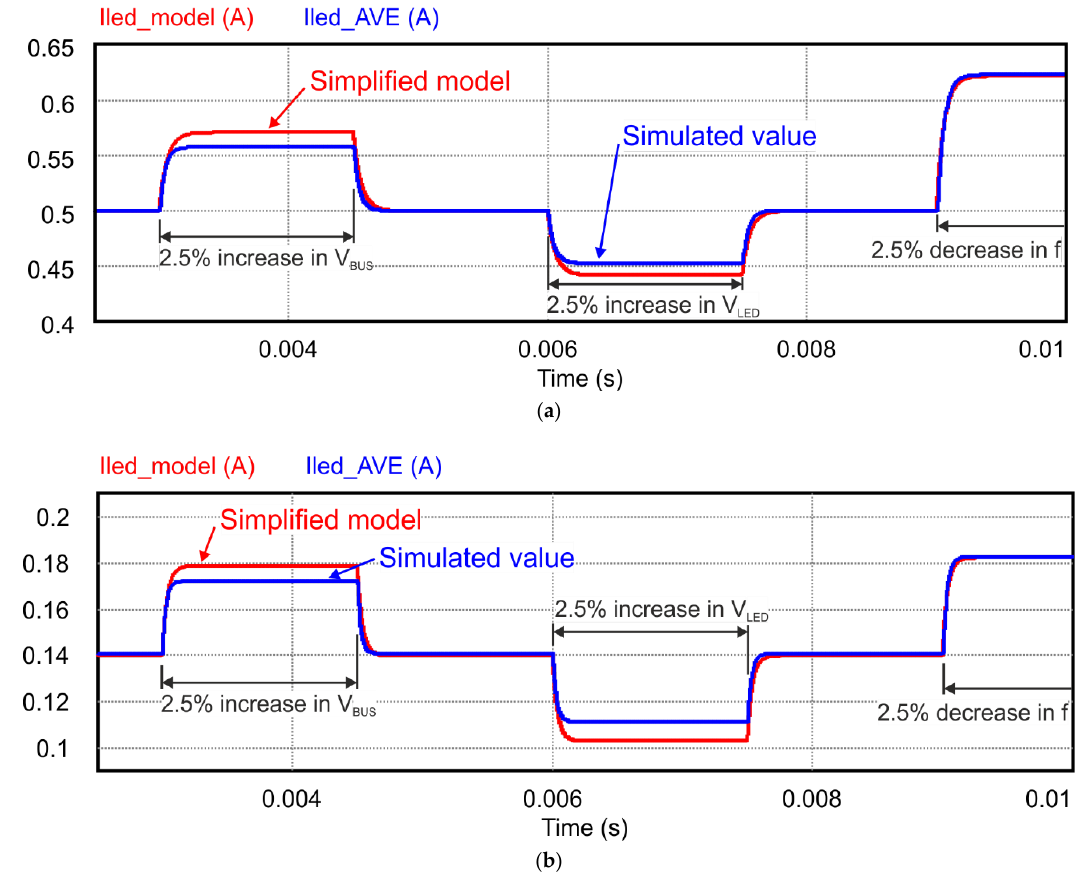
Figure 15. Simulated open-loop step-response of the actual average LED current (blue) and the proposed simplified model (red): ( a ) at nominal power; ( b ) for i LED equal to 0.14A.